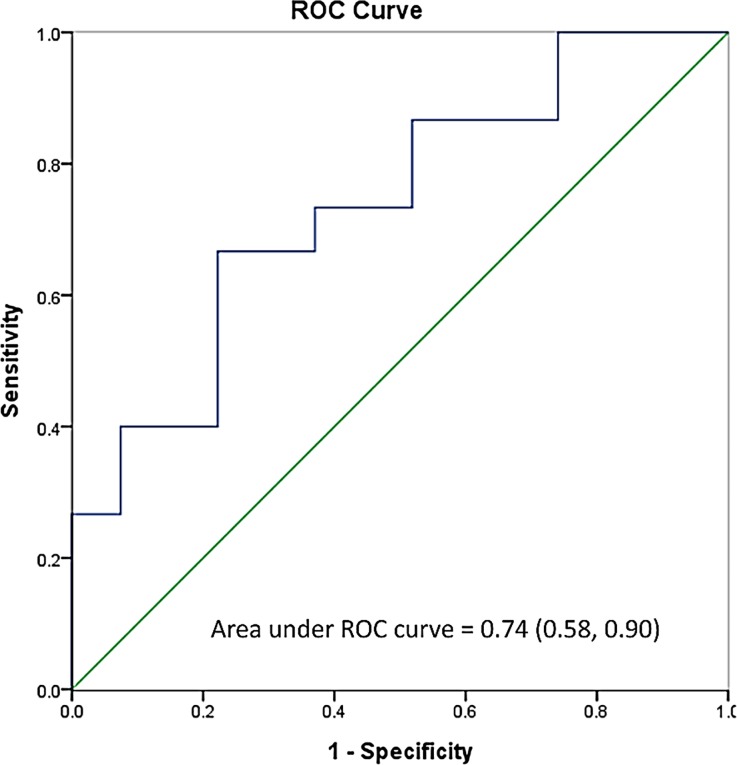
The receiver operating characteristic (ROC) curve of the Cpre-HD/MIC at the cut-off value of 18.6 for the prediction of treatment outcomes.CI: confidence interval.